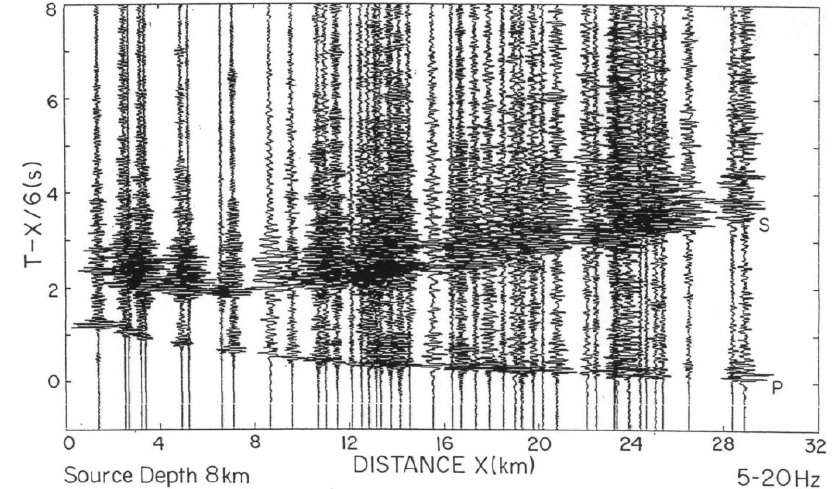
Figure 8. Composite observed record section with amplitudes normalized, in the epicentral distance versus reduced time (reduction veloc- ity 6 km/s) frame, assembled from processed seismograms of local earthquakes with average source depth of 8